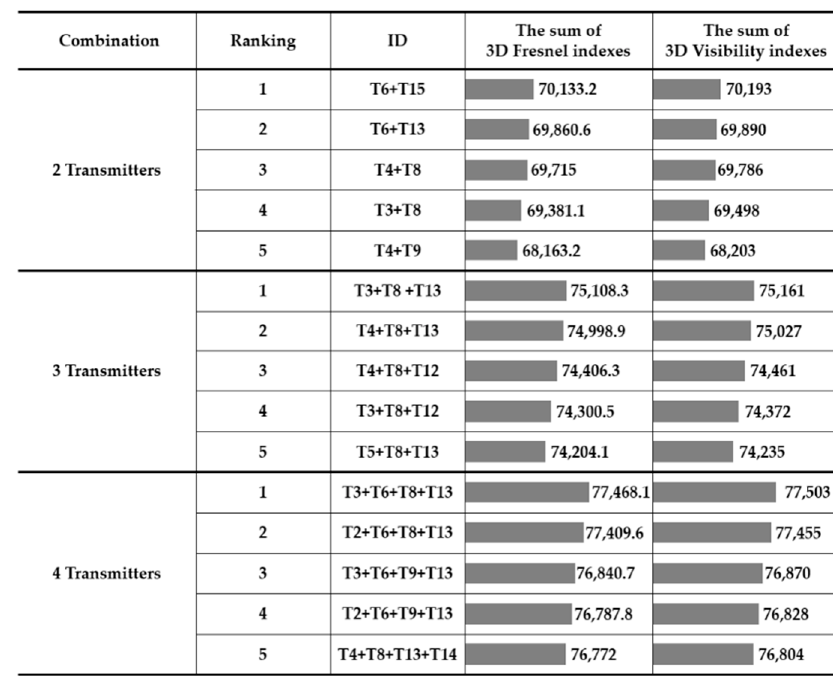
Figure 10. Ranking of transmitter combination candidates selected by considering the sum of 3D Fresnel indices and the sum of 3D visibility indices.